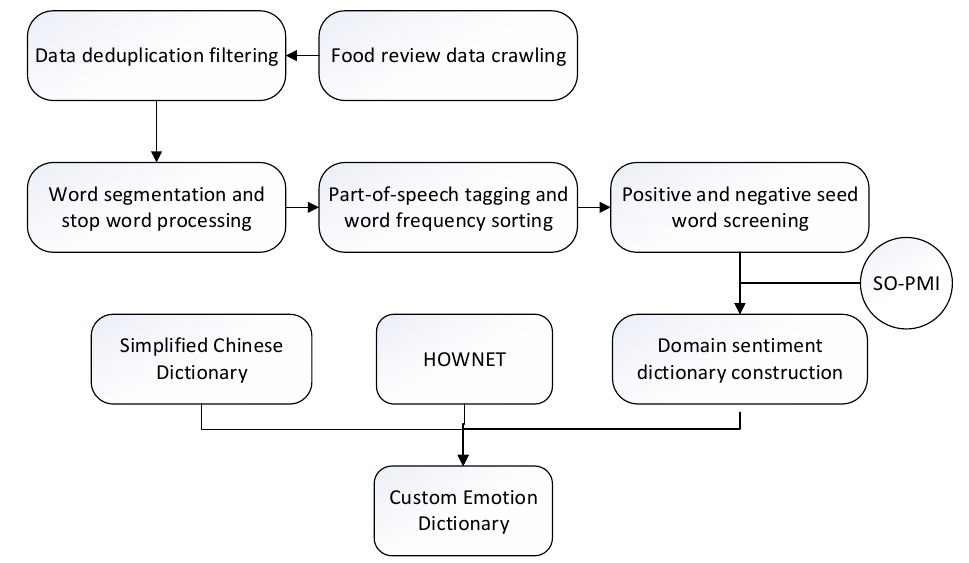
Figure 2. The construction process of a custom sentimental dictionary.